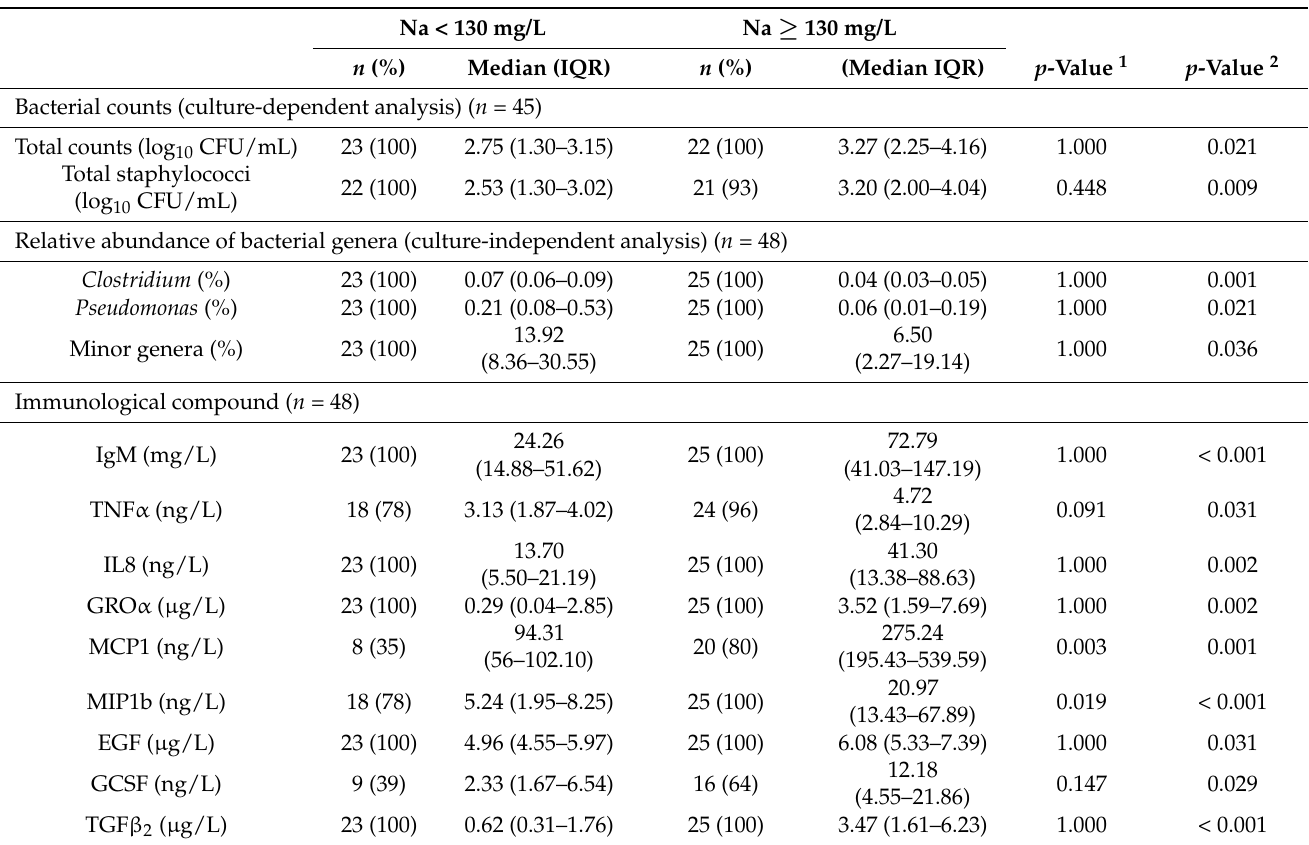
Table 4. Frequency and concentration of microbiological counts, microbial relative abundances and immunological compounds according to the content of Na in the milk samples. Na < 130